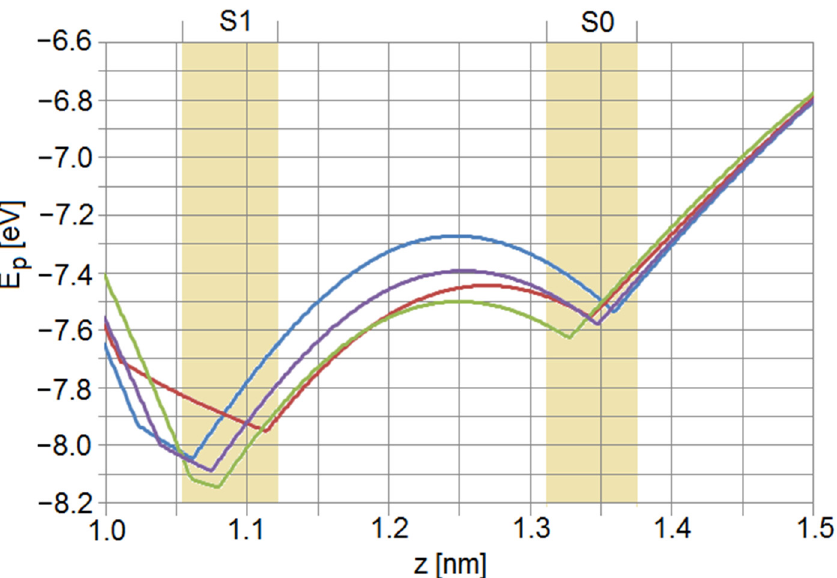
Figure 7. Four snap shots of potential Ep of a K + ion in the region between S1 and S0 taken within a few ps. The filter has occupancy K0W1K2W3K4 and standard length as in the central image of Figure 3. The fluctuations of the carbonyl oxygens, which are essentially Boltzmann-distributed by random exchanges with the thermal bath, lead to constantly changing barrier heights between S1 and S0. In these examples they range between 0.51 eV and 0.77 eV (19–29 k B T), in agreement with other simulations in, e.g., [11,22].